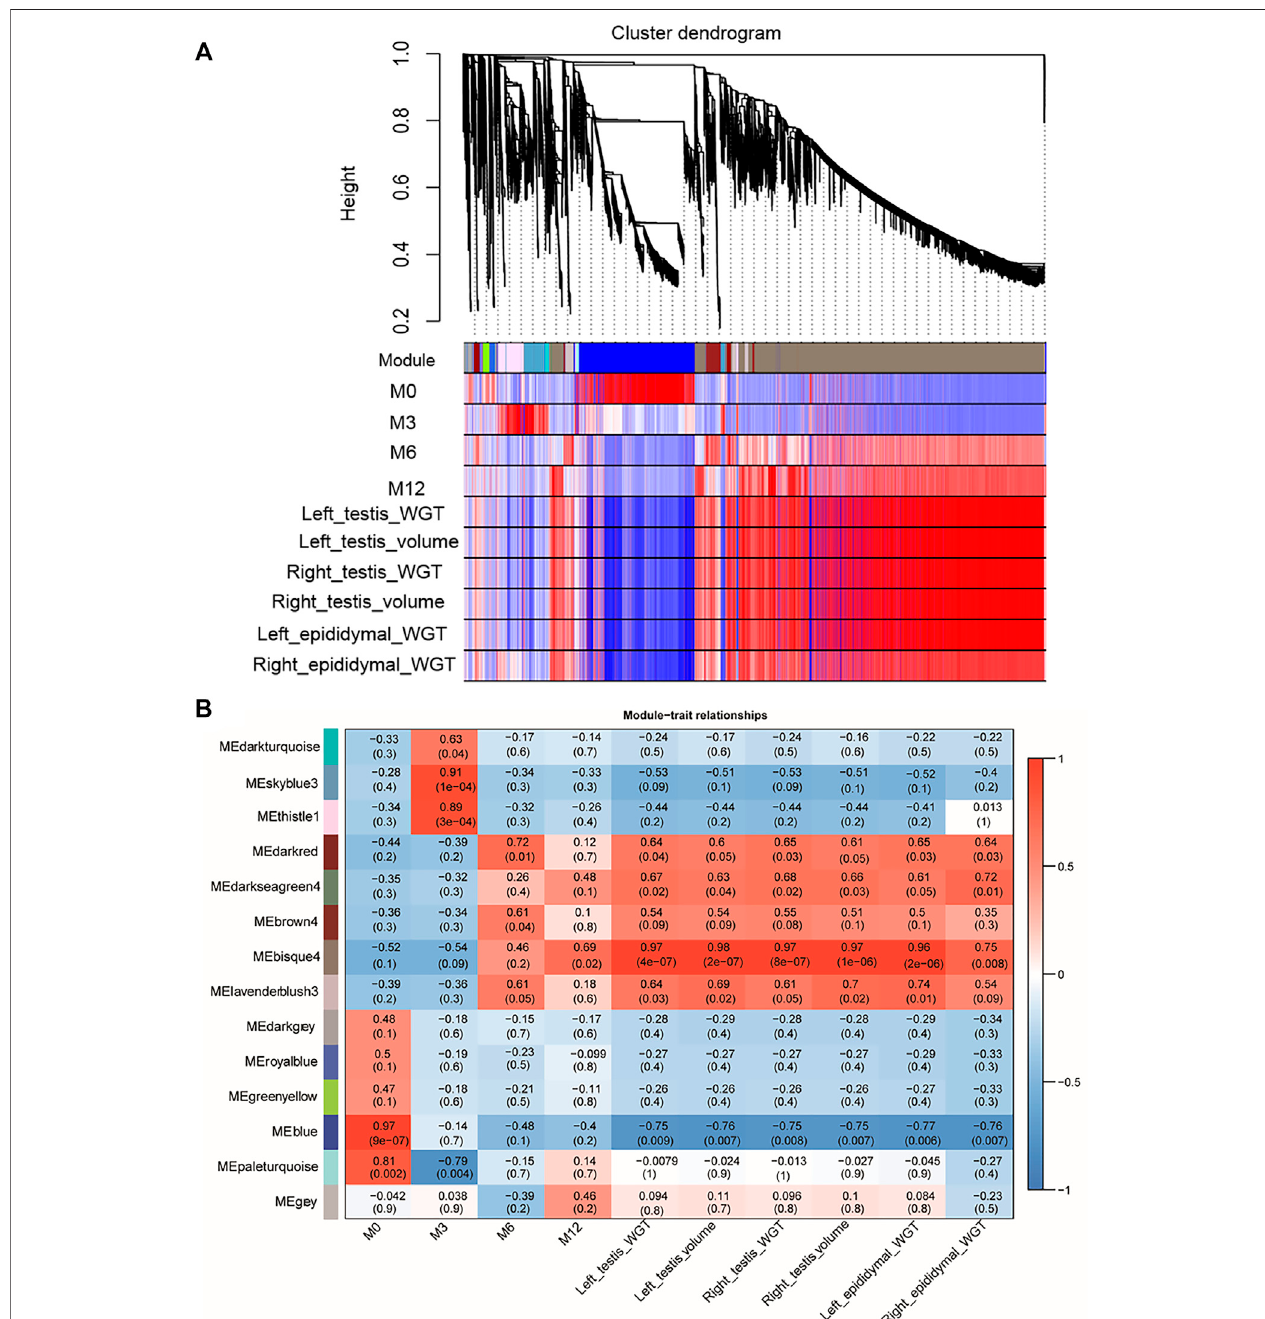
FIGURE7 | Visual representations of thegene co-expressionnetworksand corresponding genesigni fi cantbyWGCNA analysis. (A) The cluster dendrogramofall genes obtained from all samples. Hierarchical clustering of all genes constructed from four development phase testis of Hu sheep. The colored bars (below) directly correspond to the module (color) designation for the gene clusters. Fourteen distinct gene modules or groups of genes with high topological overlap were identi fi ed. To distinguish between modules, we designated each module with an arbitrary color; grey modules represented poorly connected genes. (B) The relationships between gene modules and traits (development time point and phenotypic traits) in the testis of sheep at different stages. The y -axis shows the 14 gene modules constructed by WGCNA. The x -axis shows the phenotypic traits, including Left testis weight (WGT), left testis Volume, Right testis WGT, Right testis volume, Left epididymal WGT, and Rightepididymal WGT. In each cellof thetable,the upper valueshows the coef fi cient ofcorrelation(r) between genemodule and phenotypic trait, whilethelowervalueindicatesthestatisticalprobability.Redtobluecolorationofthecellsindicatesthetransitionfrompositivetonegativecorrelation,asindicatedbythe color